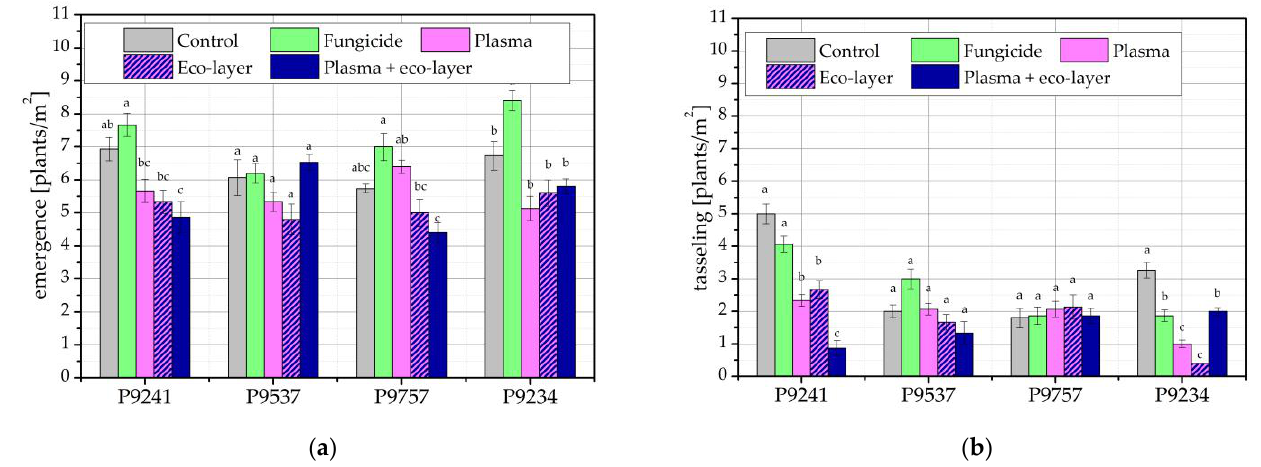
Figure 1. Number of maize plants in two vegetative growth stages of maize in the harvest year 2020: ( a ) at seedling emergence; and ( b ) at tasseling time. The error bars represent standard error. Different lowercase letters above data points represent statistically significant differences ( p < 0.05; post hoc Tukey’s range test) between treatments.